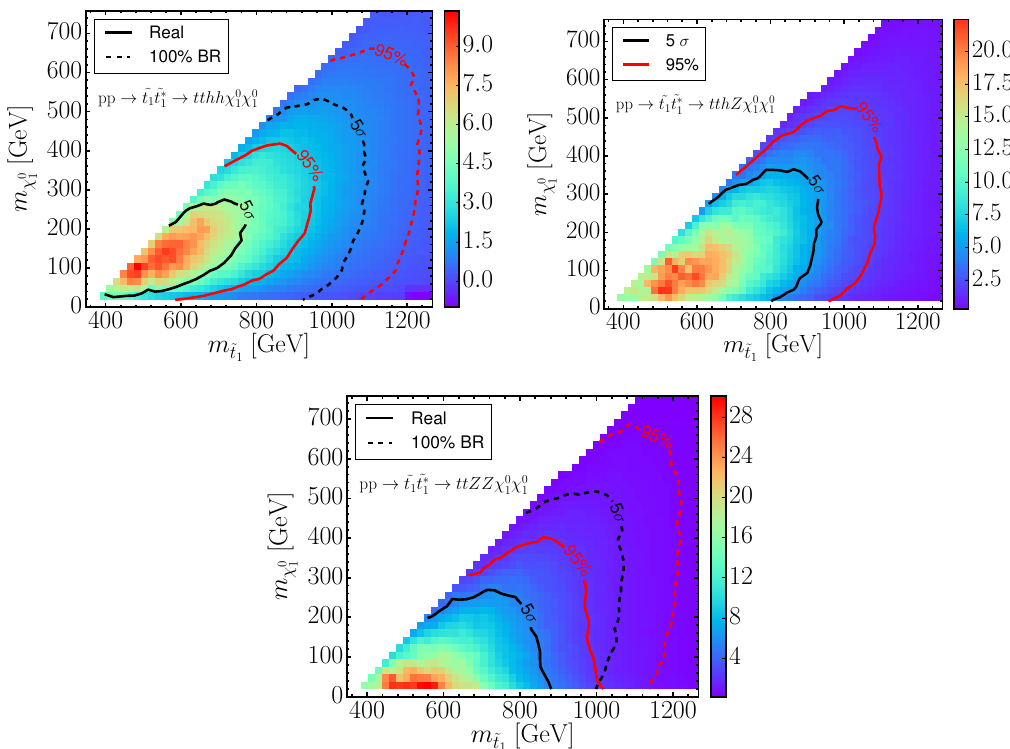
Figure 8 . The 95% CL upper limits (black curve) and 5 (cid:27) discovery reach (red curve) for the combination of three signal regions for the t (cid:22) thh E panel), t (cid:22) tZZ channel (bottom panel) at the 14 TeV LHC with 300 fb (cid:0) 1 integrated luminosity. T 6 The dotted line in the top left (bottom) panel represents the reach of the channel t (cid:22) thh assuming a 100% decay branching